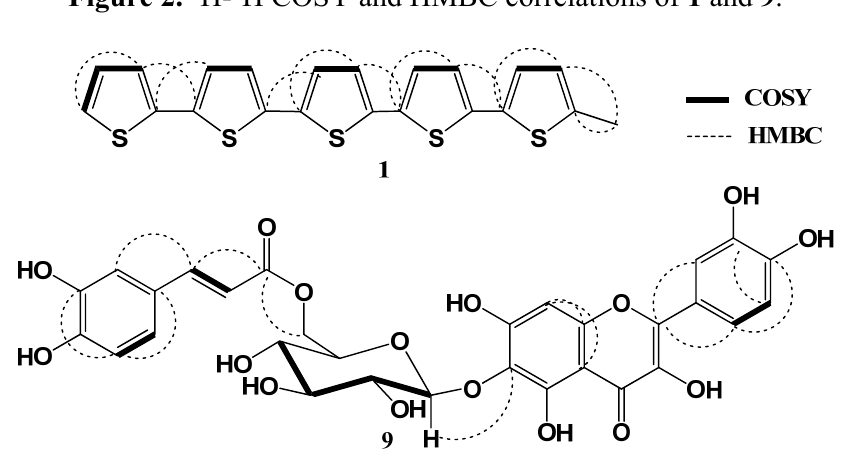
Figure 2. 1 H- 1 H COSY and HMBC correlations of 1 and 9